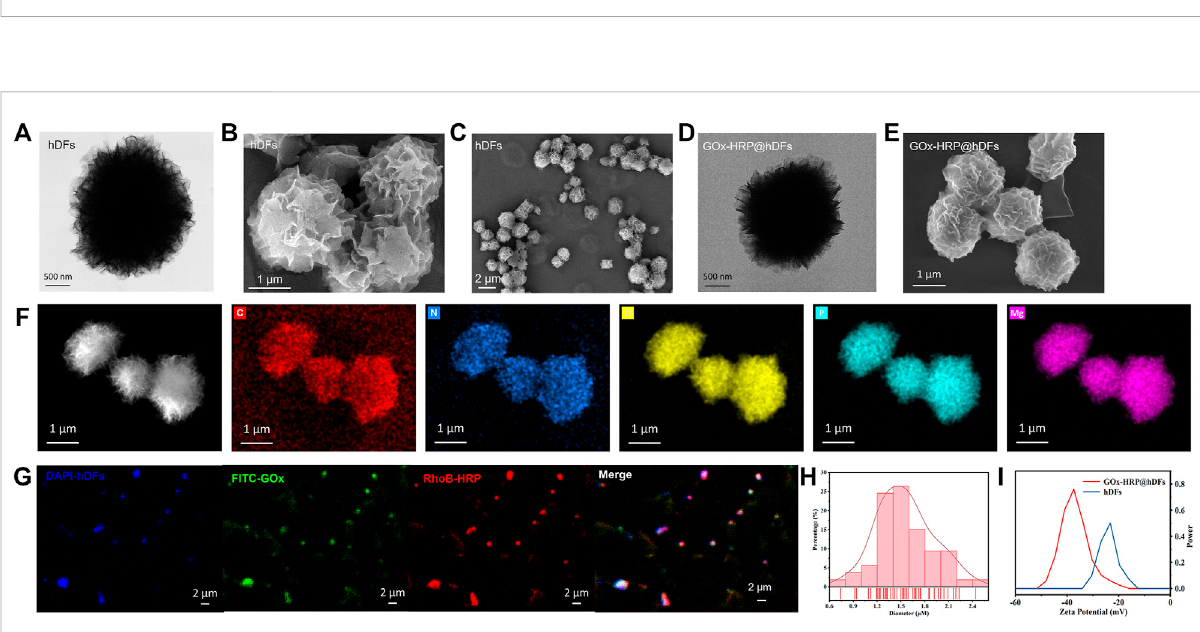
FIGURE 1 Schematic illustration of the preparation of hDFs through the one-pot RCA process, coimmobilized of GOx and HRP in hDFs via the DDI technique, and the mechanism for glucose detection using GOx/HRP@hDFs.